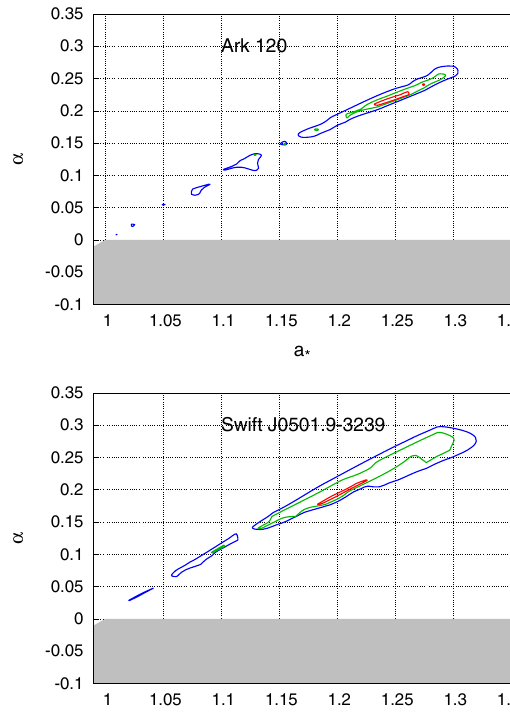
level limits for two relevant parameters ( (cid:5)χ 2 = 2 . 30, 4.61, and 9.21, respectively). The gray region is ignored in our study because it is the parameter space with naked